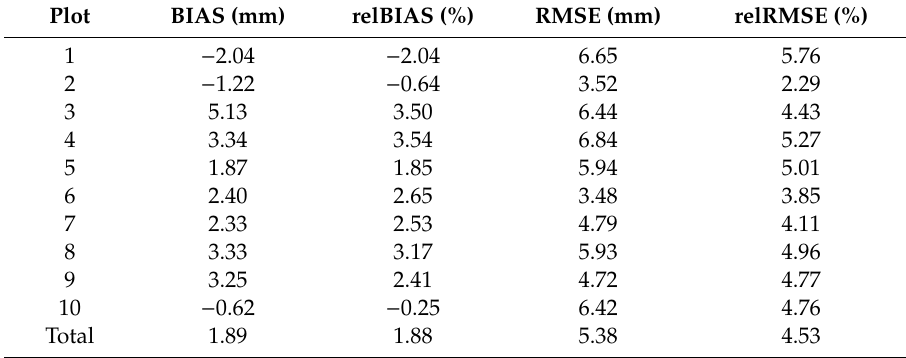
Figure 12. Distribution of the error in DBH for different tree (DBH) sizes. Table 3. Accuracy of DBHs measured by the device based on a comparison with the reference DBHs measured by a caliper.